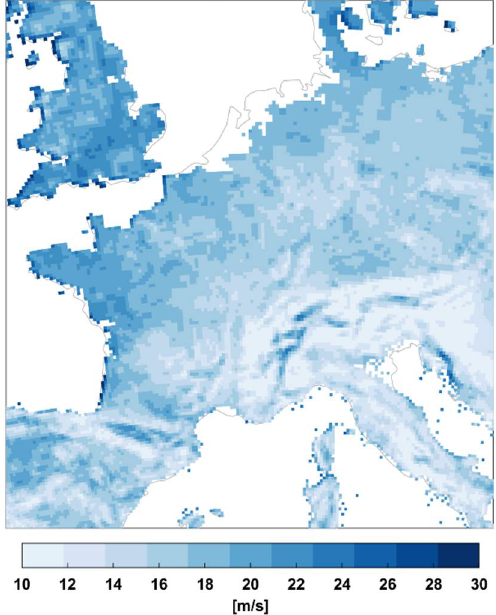
Figure 5. Map of characteristic values of wind velocity derived from the UERRA dataset for the period 1981 – 2020.